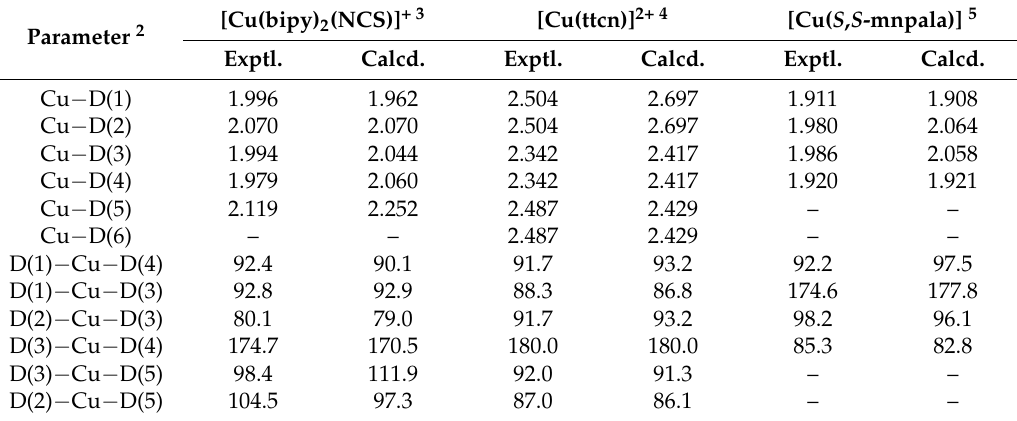
Table 1. Selected bond distances (Å) and angles (degree) for some Cu(II) complexes 1 . Parameter